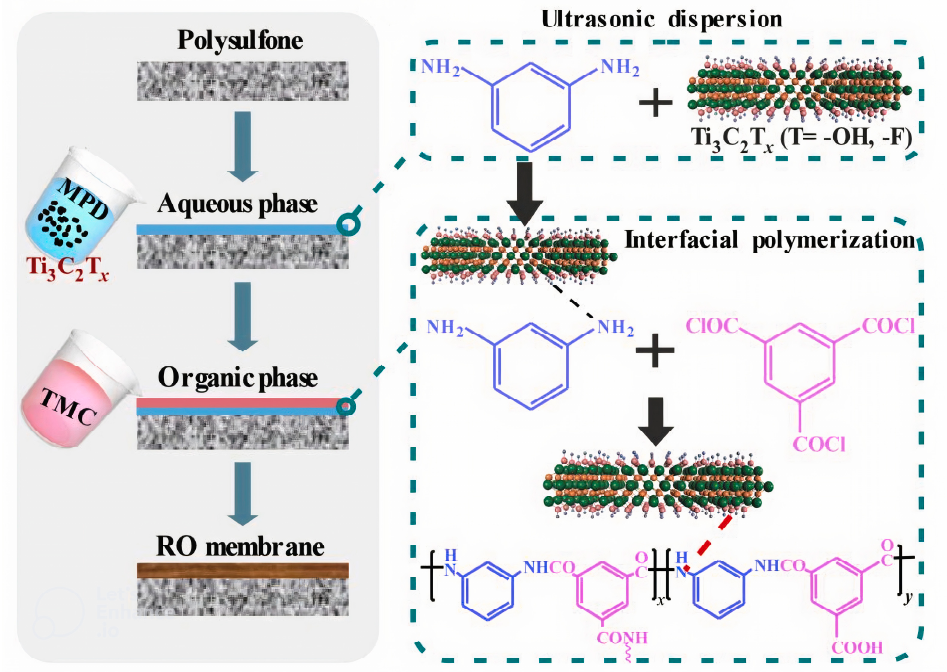
Figure 14. Synthesis of polyamide membrane [228].